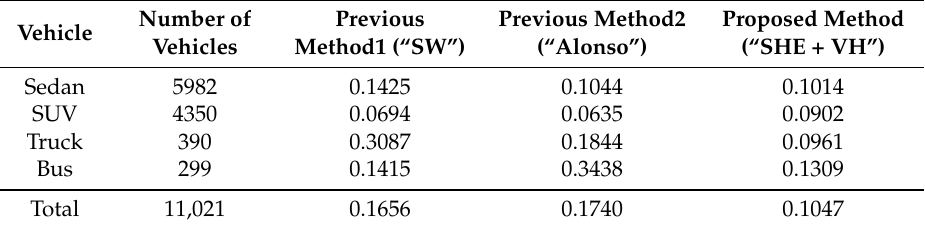
Table 2. The mean absolute errors (MAE) with the proposed and previous methods.